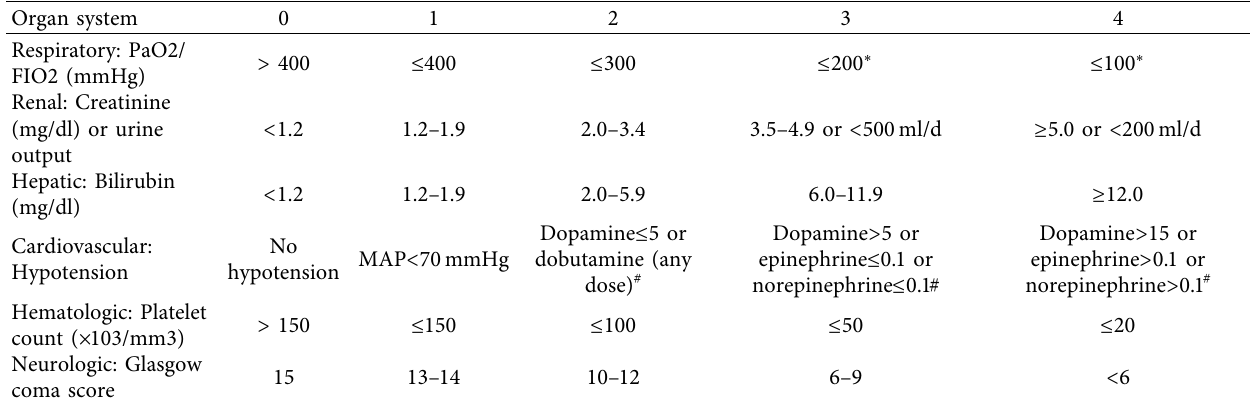
Table 1: Sequential organ failure assessment